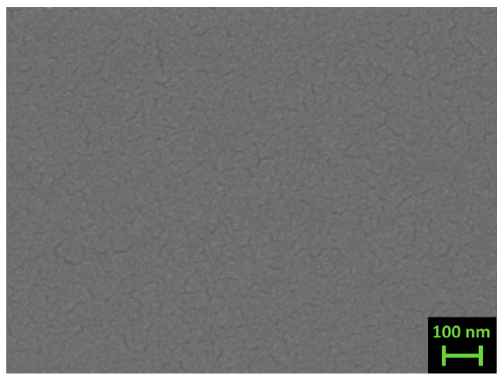
Figure 6. Top view LED-SEM images of samples ( a ) Fe70_RT, ( b ) Fe70_ann and ( c ) Fe70_423.